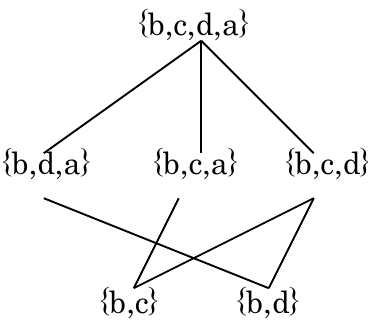
Fig. 3. Relation among reducts, modified reducts and the extended reduct